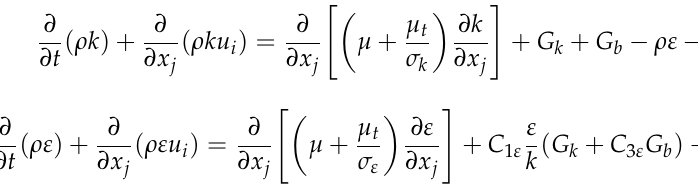
Figure 1. Mixed-flow pump model. ( a ) Inlet Section; ( b ) Impeller Section; ( c ) Guide vane Section; ( d ) Annular cochlear chamber; ( e ) Outlet section.